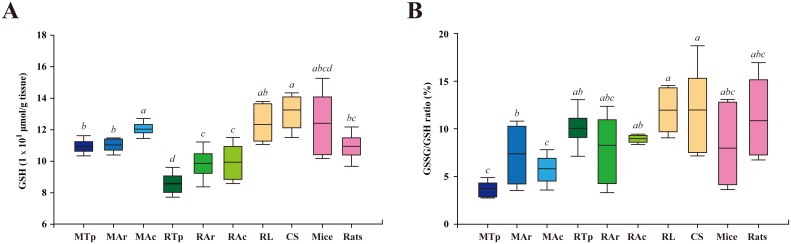
Total levels of GSH and the ratio of GSSG/GSH.(A) Total amounts of GSH (μmol/g tissue) and (B) GSSG/GSH ratios of the following were determined: M. ricketti bats at torpor (MTp), arousal (MAr), and active states (MAc); R. ferrumequinum bats at torpor (RTp), arousal (RAr), and active states (RAc), non-hibernating bats R. leschenaultia (RL) and C. sphinx (CS), mice, and rats. Box plots show the mean, 25/75 percentiles (box), and 10/90 percentiles (bars). Values of group means are represented by italicized letters and are in order of a > ab > abc > abcd > b > bc > c > cd > d. The difference in value is significant (P < 0.05) between different letters.